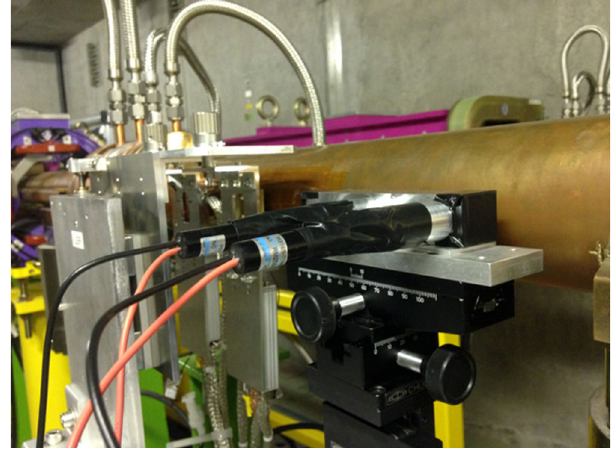
FIG. 12. The square root of the horizontal (blue) and vertical (red) β functions at the scattering positions from ≈ 100 meters upstream of the IP to the drift about 11 meters after the IP.